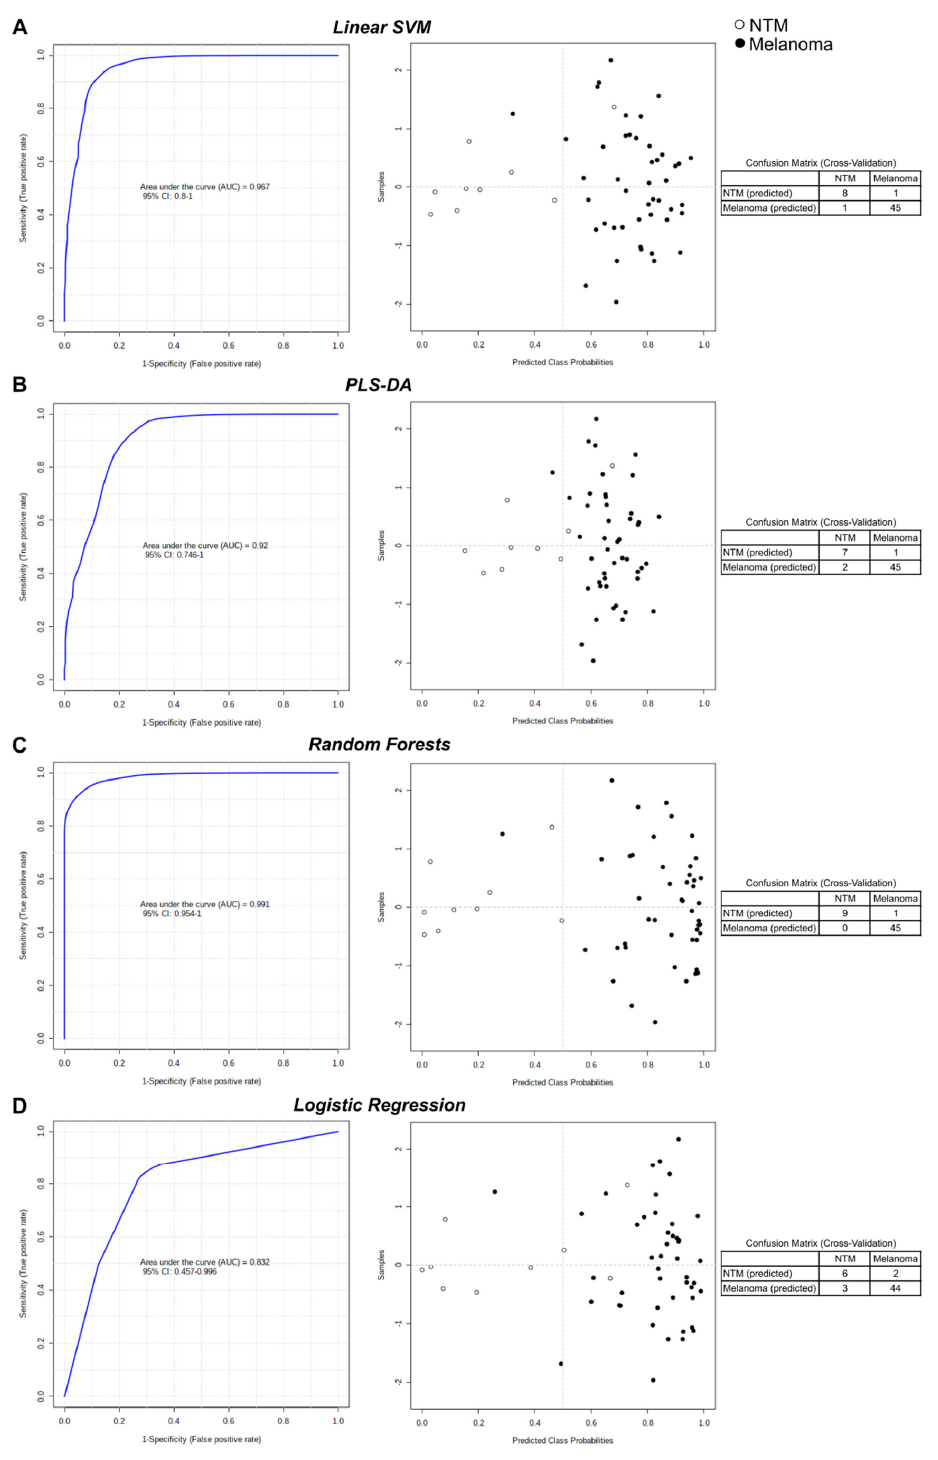
Figure 9. Evaluation of combined biomarker models. Biomarker models based on seven identified biomarker candidates (beta-alanine, p -cresol sulfate, sarcosine, tiglylcarnitine, Hex2Cer (d18:1/16:0), Hex2Cer (d18:1/20:0), and PC ae C42:4) were